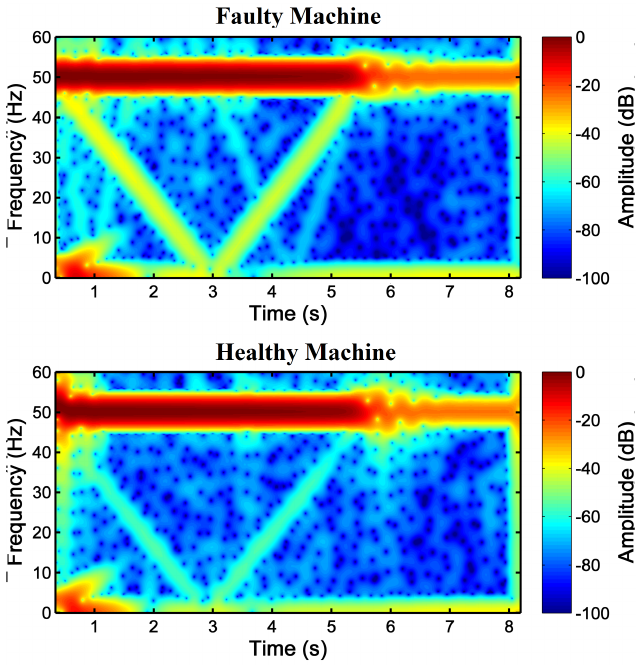
Figure 14. Spectrogram of the stator current computed with the proposed Slepian window, optimized for detecting the LSH during the start-up of the high-power, high-voltage IM given in Appendix B, with a broken bar ( top ) and in healthy conditions ( bottom